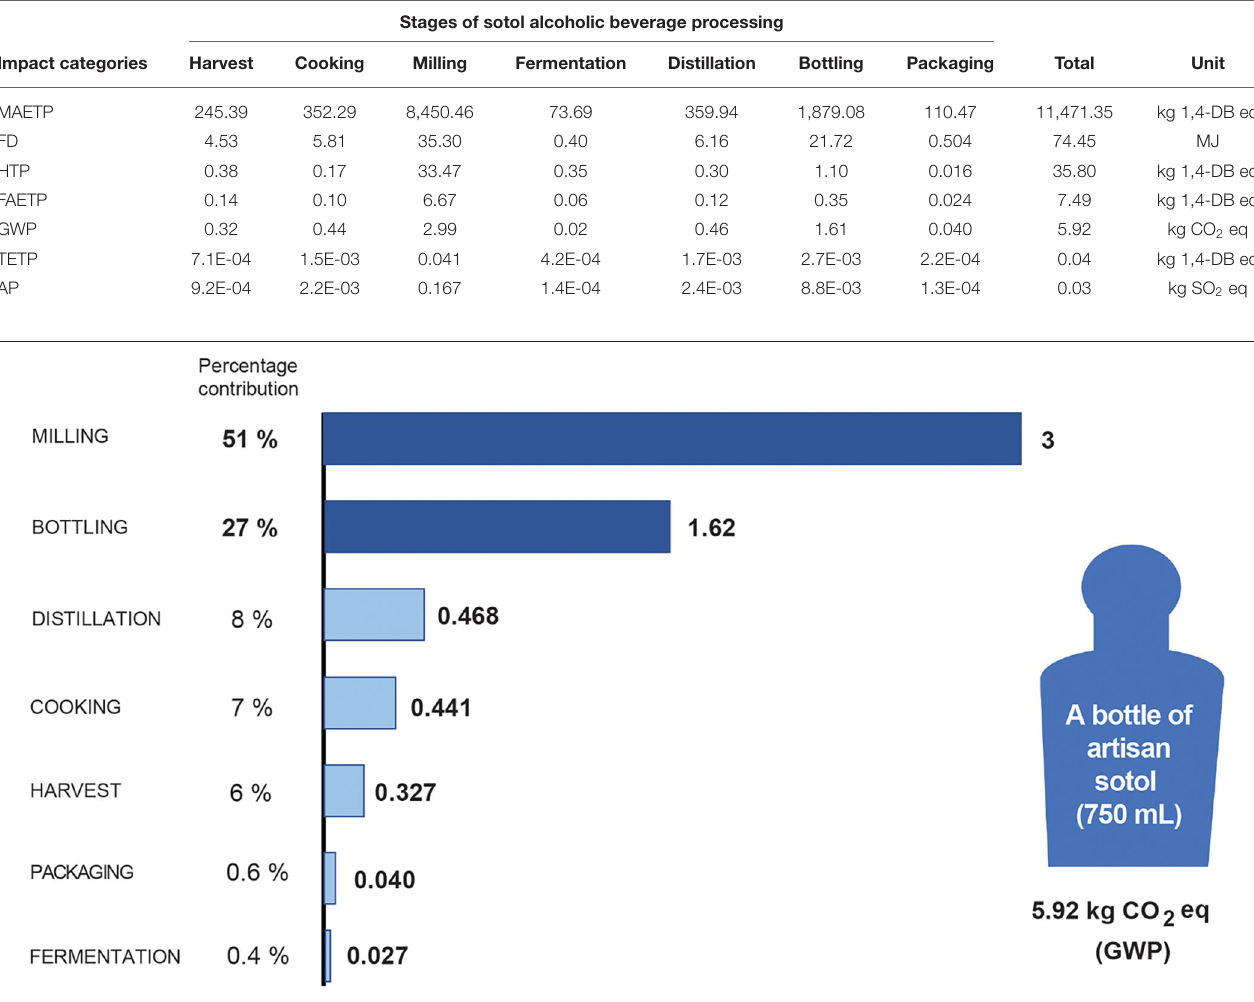
TABLE 3 | Main categories of environmental impact of the ACV of a 750-ml bottle of sotol. Stages of sotol alcoholic beverage processing